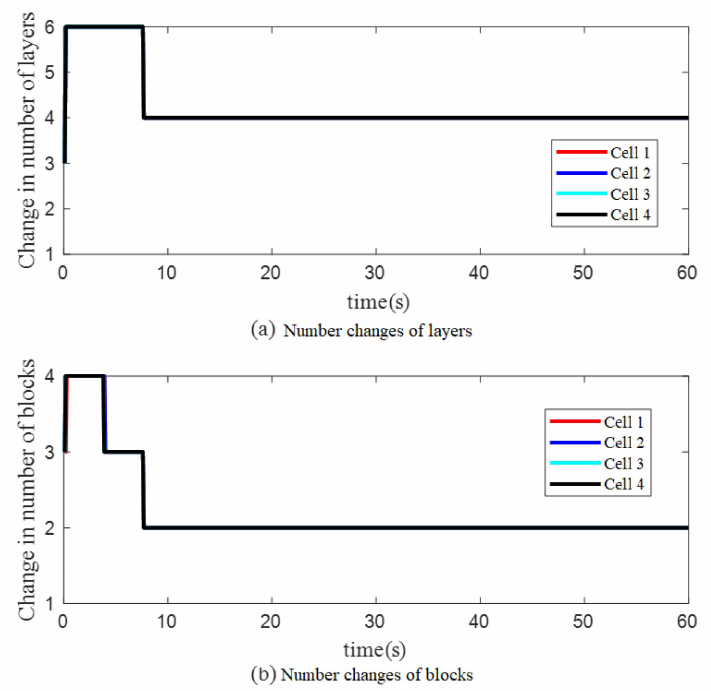
Figure 14. Changes in NSOFCMNN structure (multi-cell